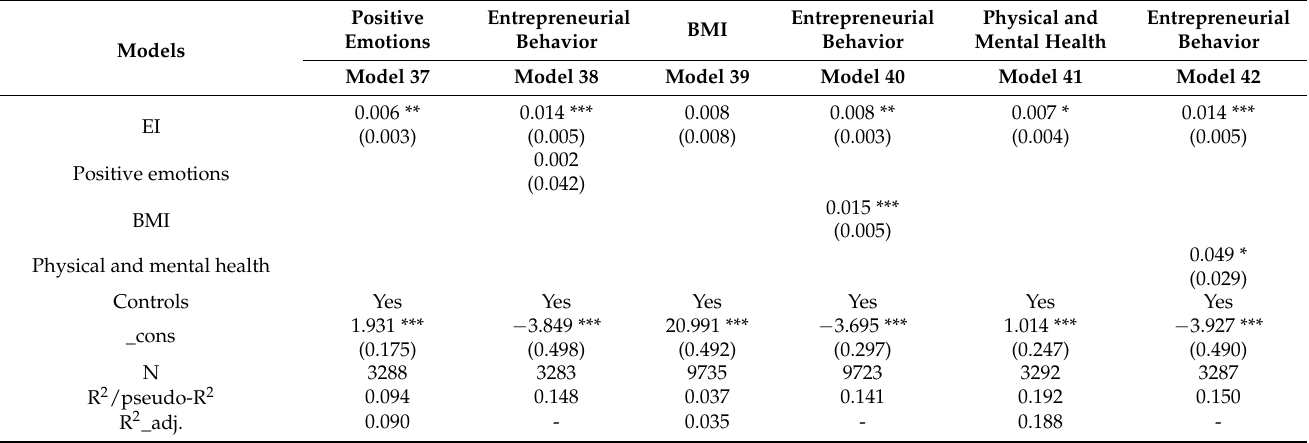
Table 8. Mediating effect test for the relationship between exercise intensity and entrepreneurial behavior.